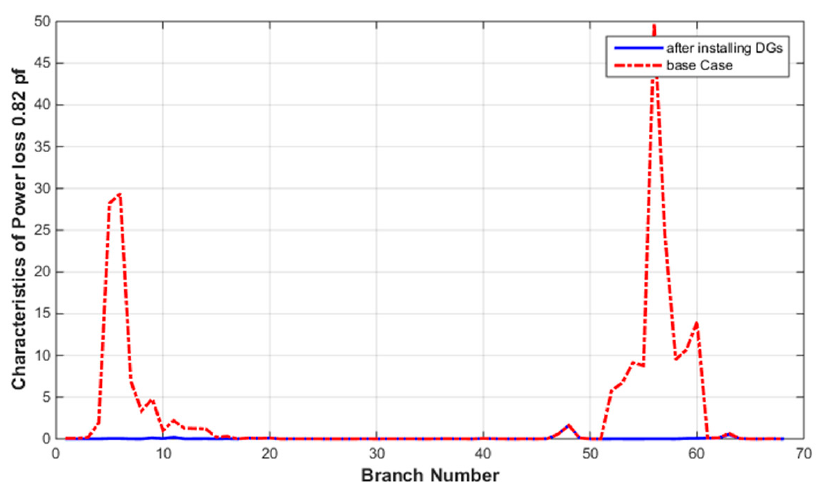
Figure 26. Characteristics of power loss at 0.82 pf.